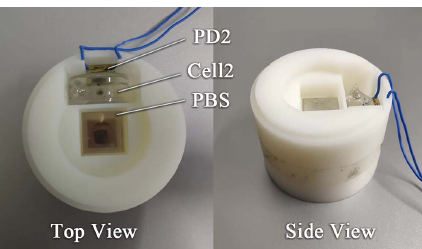
Figure 4. A vacuum atomic cell and a photodiode are added to the original structure.